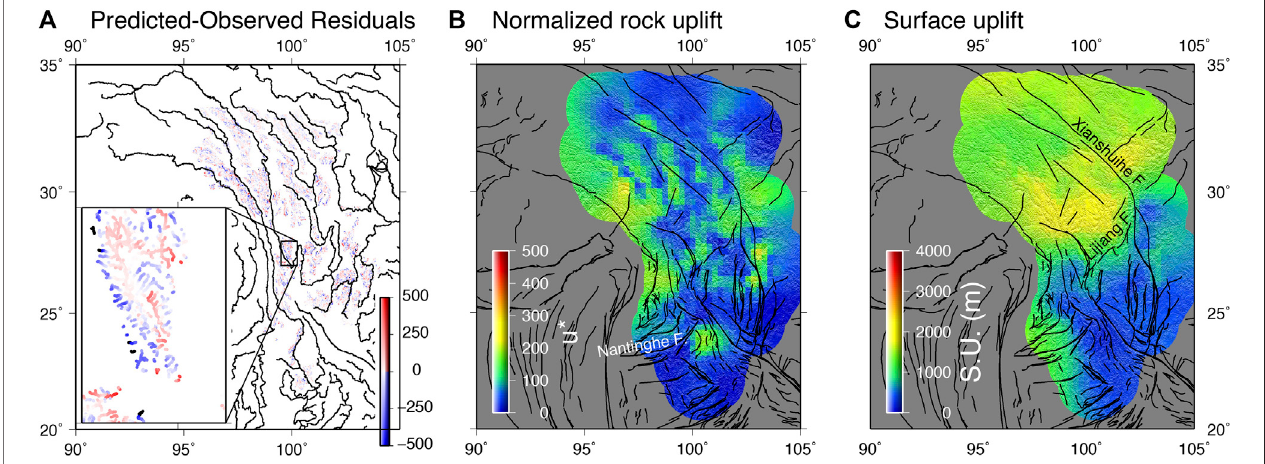
FIGURE6| Investigatingtheresultsoftheinversion. (A) Thepredicted-observedresidualsforthelow-reliefsurfacesshowthatinareaswherethemis fi tislargeand positive there are often negative residuals close by. This suggests that drainage divides and river capture are causing pairs of over- and under- steepened χ -elevation relationships. (B) ActivefaultsfromGEMdatabase (Styronet al.,2017)compared tothenormalizedrockupliftmapand thesurfaceupliftmap (C) .Aspectsoftheresults are controlled by active structures, see text for details.